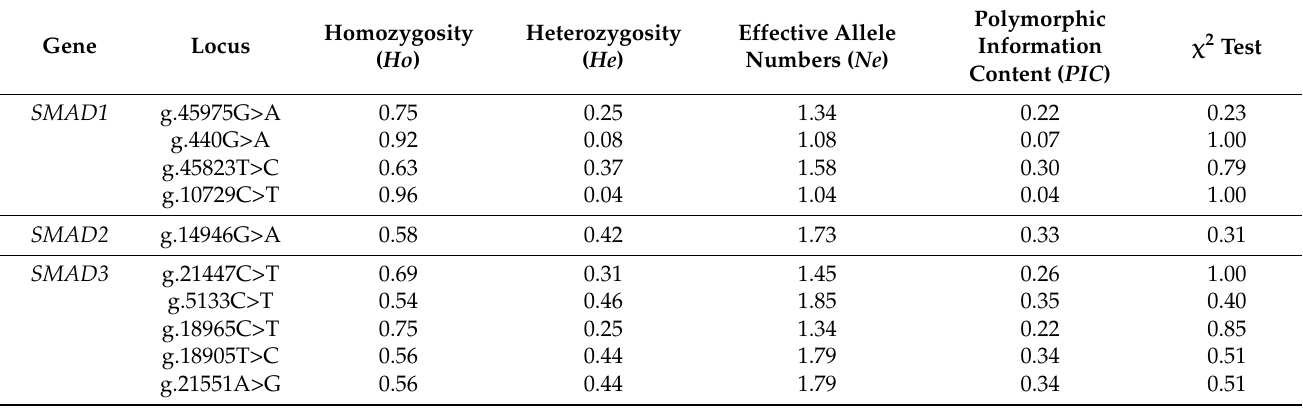
Table 4. Population genetic analysis of SNPs loci of SMAD1 , SMAD2 and SMAD3 genes in Ti- betan sheep.